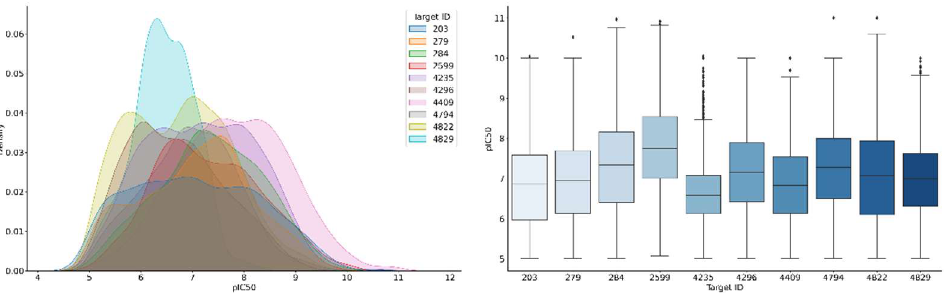
Figure 5. Potency value distribution of activity classes. Kernel density estimation plots ( left ) and boxplots ( right ) compare the potency values distributions of the 10 activity classes. Coloring of boxplots is arbitrary. The horizontal line indicates the median of the value distribution and diamond symbols represent statistical outliers.